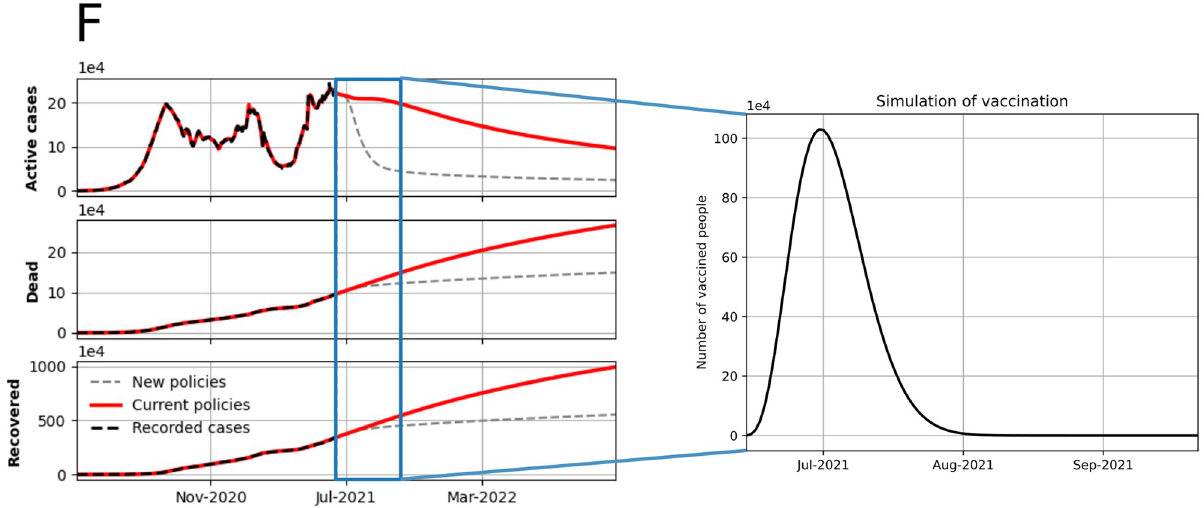
Fig 8. Model simulation using Colombia as an example. The blue line shows the limit of model fitting. After that line, we present two scenarios: one in which the simulation follows the same trend and another one in which we include vaccination policies. Here, we designed the distribution of 20000000 vaccines through an effectiveness of 0.99 and a beta distribution with parameters a = 5 and b = 20.